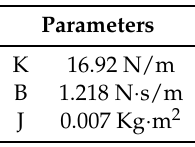
Table 3. Estimated joint parameters.